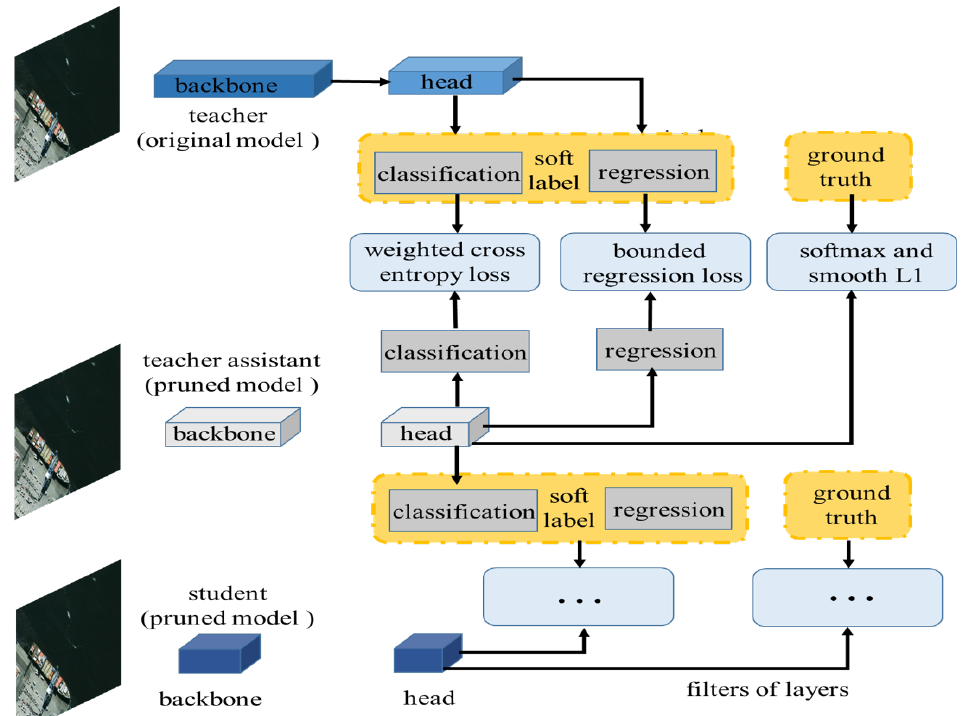
Figure 3. Assistant distillation workflow. The original network is used as a teacher, the network generated through intermediate pruning is used as a teacher assistant, and the lightweight network after iterative pruning is used as a student